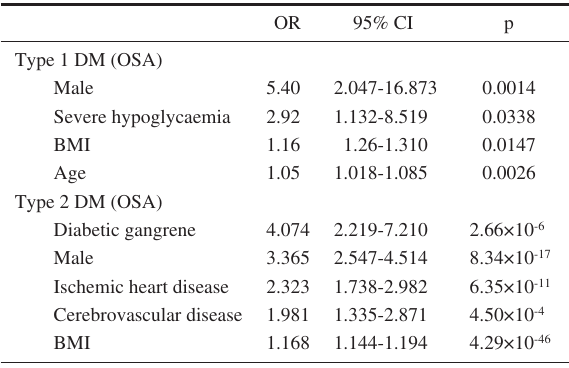
male gender, higher BMI, lower eGFR, LDLC,